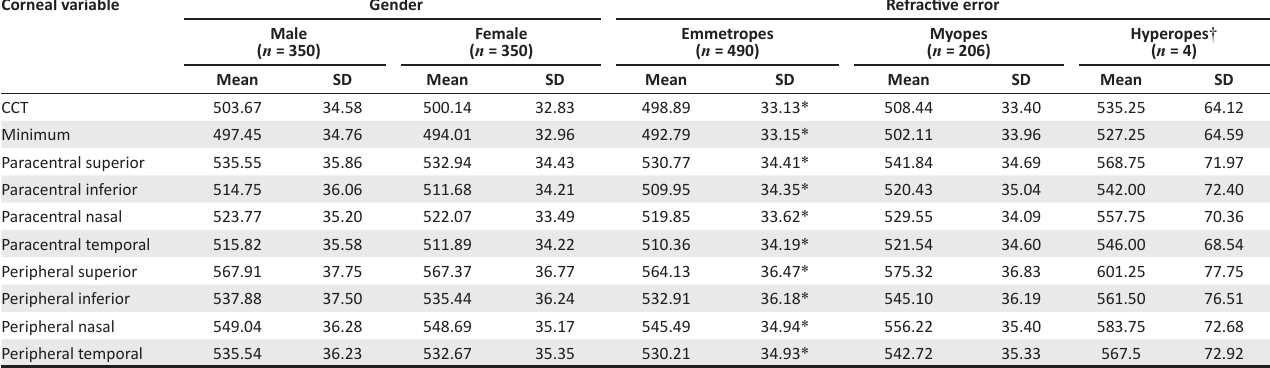
TABLE 2: Corneal thickness ( µ m) in each zone segmented by gender and refractive error indicated with means and standard deviations. Corneal variable Gender Refractive error Male ( n =